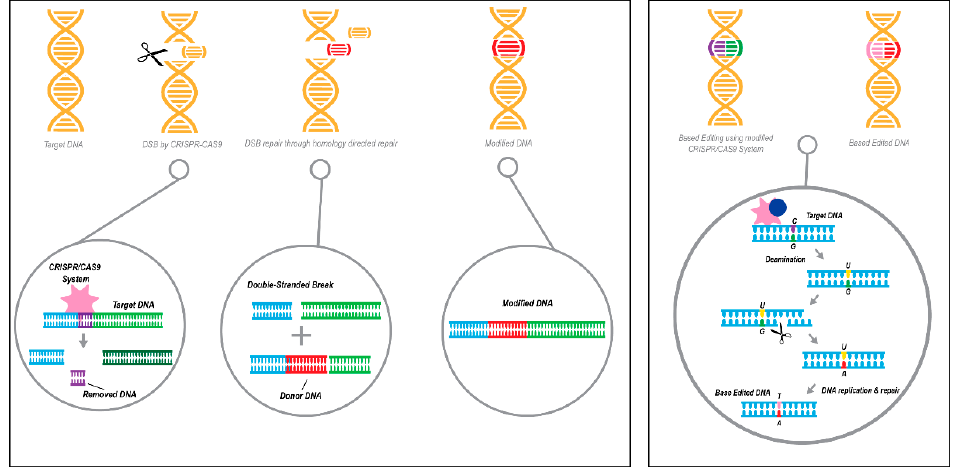
Figure 5. An illustration describing CRISPR/Cas9 technology as gene therapy approaches. Left panel: Gene editing acting on the DNA strand-level by knock-in replacement using the CRISPR-Cas9 system, resulting in targeted genomic deletion followed by homology-directed repair (HDR) with a donor DNA sequence. Orange represents DNA, red donor DNA,) Right panel: Acting on the chemistry of a single DNA base, gene editing by base editing technology utilizes the CRISPR/dCas9 or CRISPR/nickase(n)Cas9 system. Orange represents DNA, the following colors represent the 4 deoxyribonucleic acids: purple C, green G, pink T, red A.